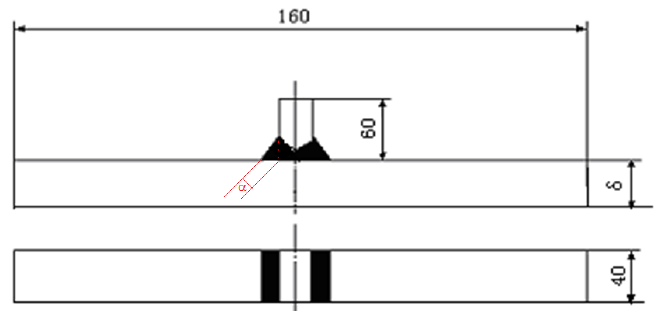
Figure 3: Size and shape of the three-point bending fatigue